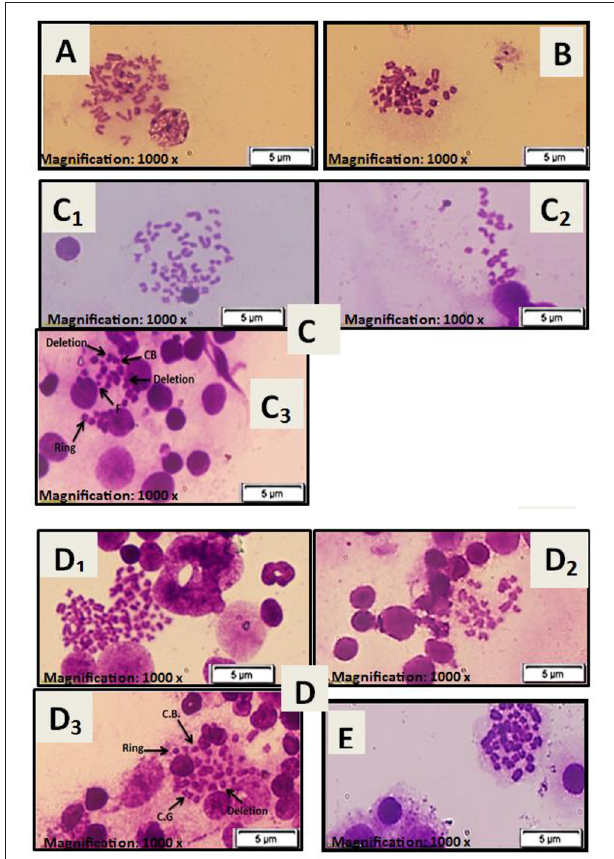
FIGURE 4 | (A) Metaphase spread of female rat bone marrow cells for the normal rat. (B) Metaphase spread of female rat bone marrow cells for rat injected with stem cells only at a dose of 1 × 10 6 cells/rat. (C) Metaphase spread of female rat bone marrow cells for the diseased group injected with only GM at a dose of 100 mg/kg: (C1) chromosomal polyploidy, (C2) chromosomal hypoploidy, and (C3) chromosomal aberrations: chromosomal break (CB), deletion, chromosomal ring (Ring), and fragments (F). (D) Metaphase spread of female rat bone marrow cells for the preventive group treated with stem cells at a dose of 1 × 10 6 cells/rat before being injected with GM at 100 mg/kg: (D1) chromosomal polyploidy, (D2) chromosomal hypoploidy, and (D3) chromosomal aberrations: chromosomal break (CB), deletion, chromosomal ring (Ring), and chromatid gap (CG). (E) Metaphase spread of female rat bone marrow cells for the treated group injected with GM at a dose of 100 mg/kg and then treated with stem cells at a dose of 1 × 10 6